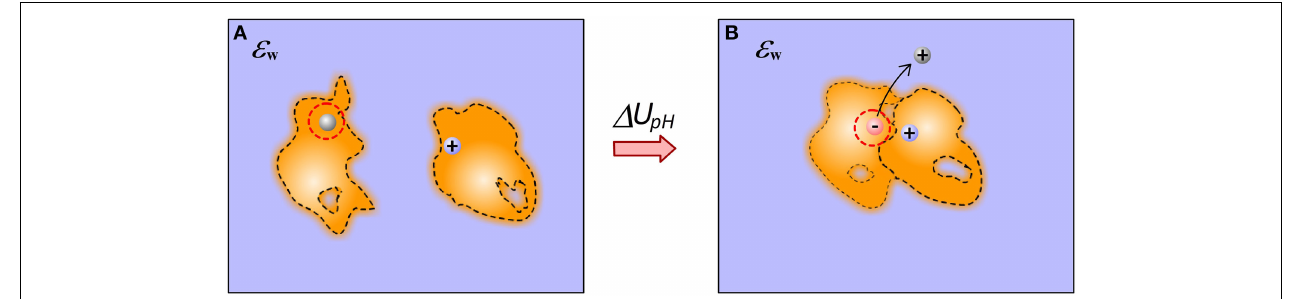
FIGURE 5 | Schematic illustration of proton release induced by the binding. (A) Monomers; (B) Complex. The binding causes a particular acidic group, being uncharged in unbound state, to be